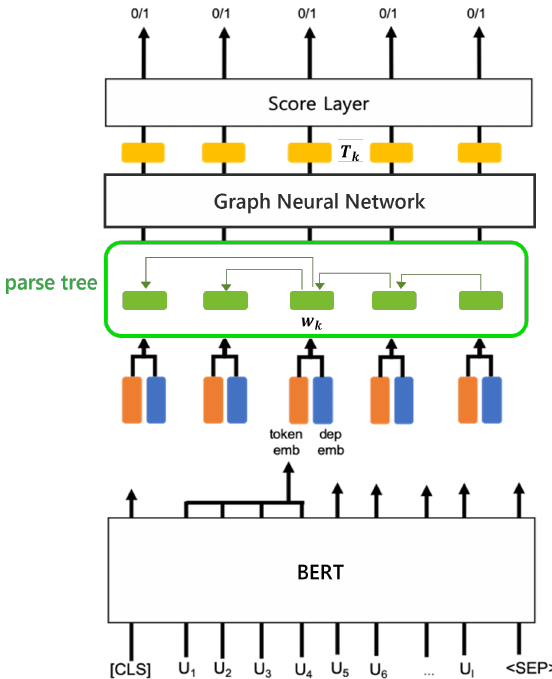
Figure 2. Sentence compression model with a